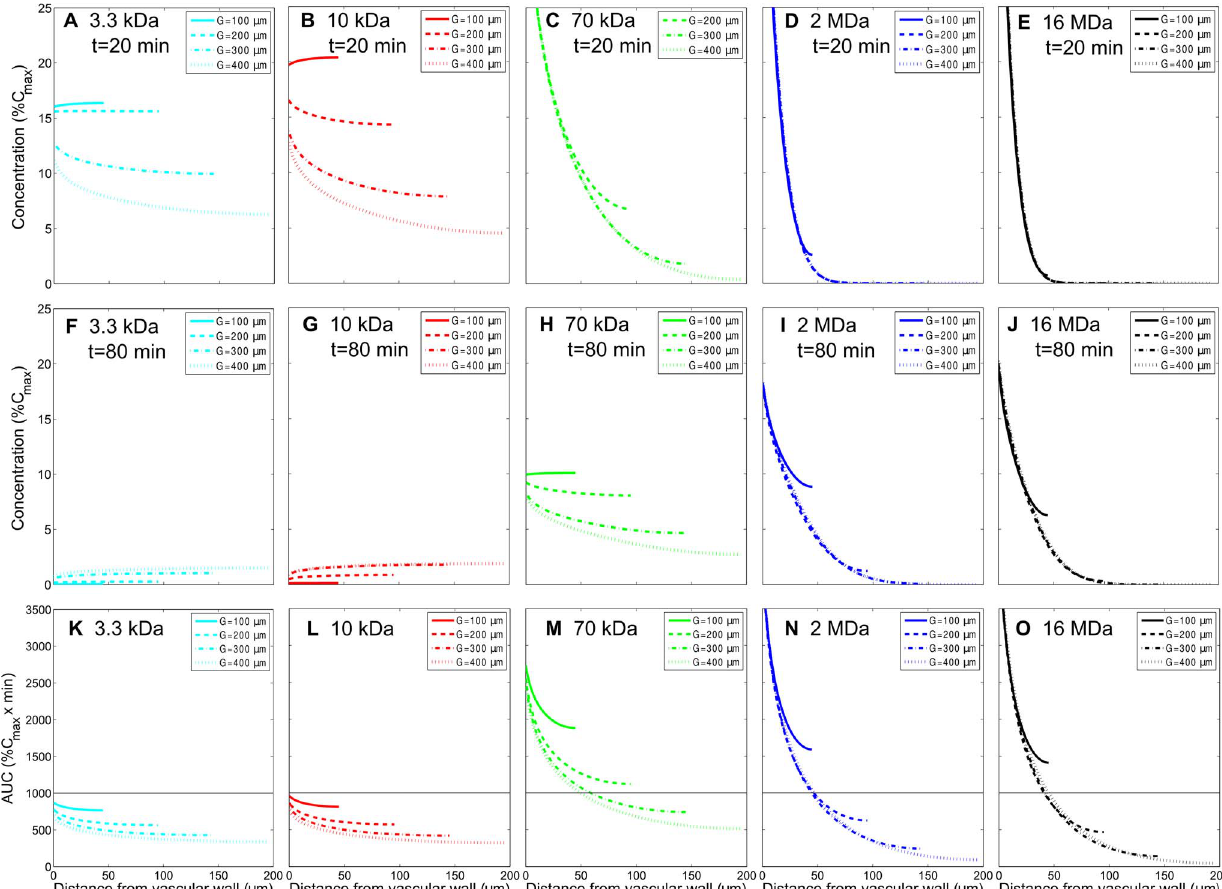
Figure 4. Effect of vascular density on the spatial distribution of instantaneous concentration and the accumulative exposure. The effect of vascular density on the spatial distribution of instantaneous concentration response of various macromolecular carriers (MW: 3.3 kDa, 10 kDa, 70 kDa, 2 MDa, 16MDa) at 20 min and 80 min and their accumulative exposure (in the radial distance, up to 0 : 5% C max ) in the tumor interstitium. A–E and F–J are concentration distributions at 20 min and 80 min, respectively. K–O correspond to the accumulative exposures. The horizontal lines show the value of AUC equal to 1000 % C max | min . The permeability, interstitial diffusivity, and plasma half-life time for dextrans of different molecular weights in this case are listed in Table 1. (Note that the solid curve corresponding to G ~ 100 m m is not shown in subfigure C because its values are beyond the range of those plotted).